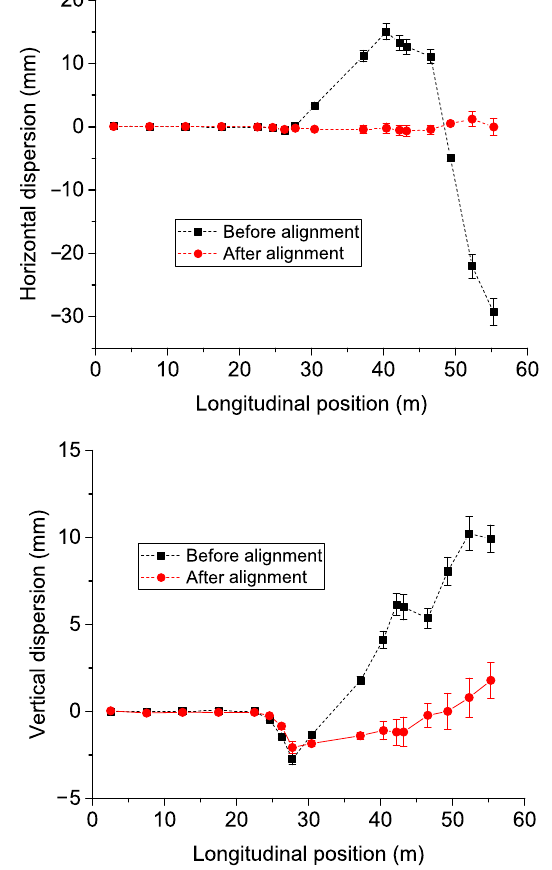
FIG. 55. Measured spurious dispersion in the horizontal (upper panel) and vertical plane (lower panel) along the injector before and after the beam-based alignment (adjustment of the reference